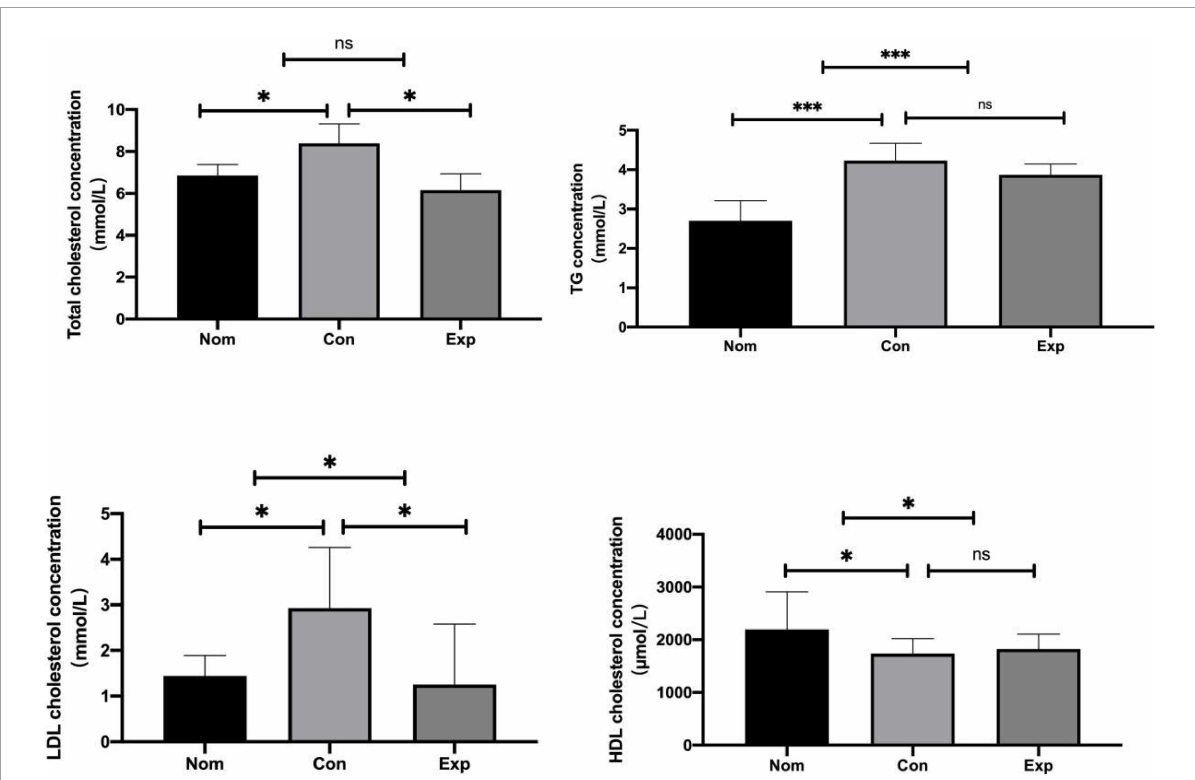
FIGURE2 β -sitosterol modulated lipid metabolism in atherosclerosis (AS) mice. Values are presented as the mean ± SD. ∗ p < 0.05; ∗∗∗ p < 0.001, ns = not